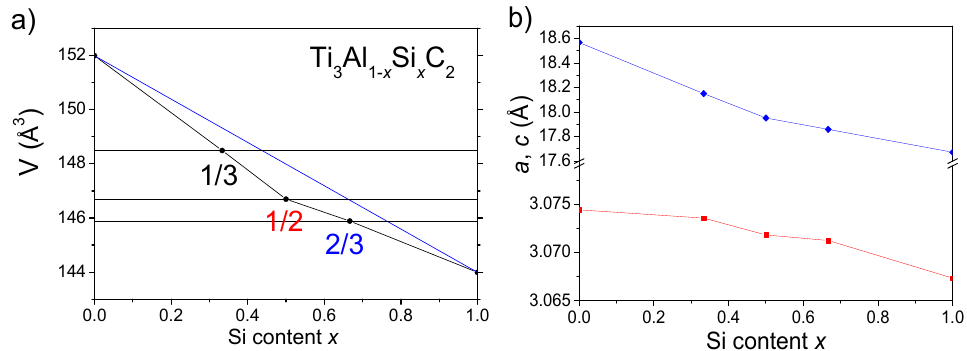
Figure 4. ( a ) Dependence of the unit cell volume V on the Si content x of the Ti 3 (Al 1− x Si x )C 2 samples (black dots). The blue solid line represents an assumed linear V ( x ) dependence. ( b ) Dependence of the unit cell parameters a (red squares) and c (blue diamonds) on the Si content x of the Ti 3 (Al 1− x Si x )C 2 samples. Errors are comprised in symbol size.